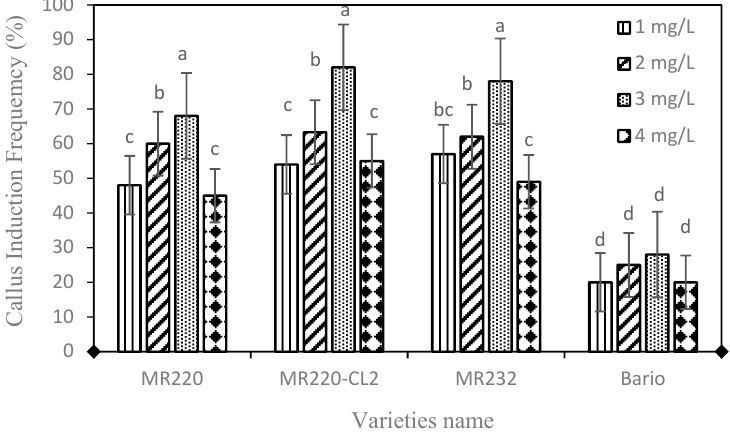
Figure 1. Calli induction frequency in four indica rice varieties (MR220, Mr220-CL2, MR232, and Bario) supplemented with different concentration of 2,4-D (2, 4-dichlorophenoxyacetic acid) on MS (Murashige and Skoog) basal media after 3 weeks of culture. Mean values of calli induction frequency marked with the same letters do not differ significantly ( P ≤ 0.05) in Tukey’s test. Vertical bars represent ± SD ( n = 3).